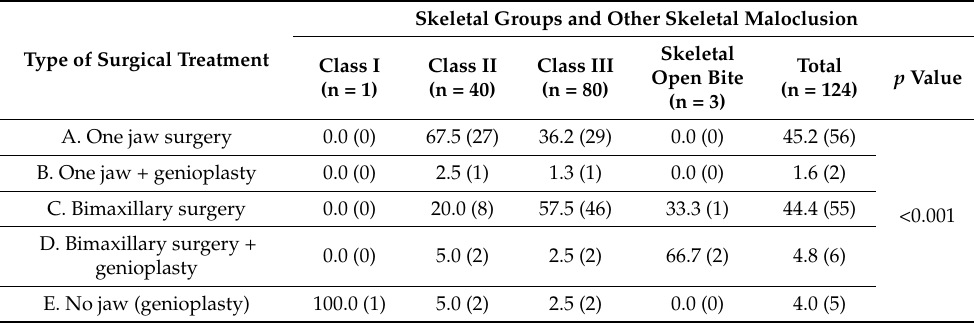
Table 5. Incidence type of surgical treatment according to skeletal groups and other skeletal maloclusion.